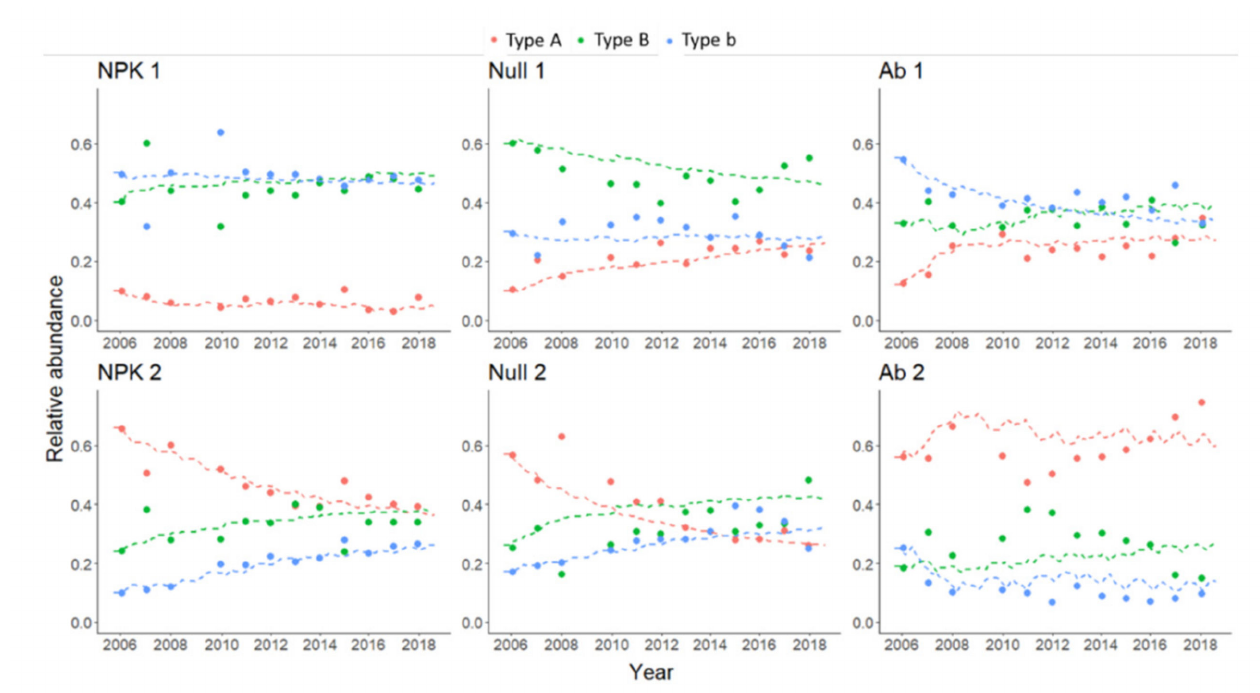
Figure 3. Observed (dots) and ModVege-CoSMo simulated (lines) fluctuations in the relative abun- dance of plant (grass) functional types in three treatments (NPK: fertilised; Null: unfertilised; Ab: abandoned) and two blocks (1, 2). Type A: grass species of fertile environments, small, with early phenology and a short life span of the leaves; Type B: grass species of fertile environments, larger, with moderately early phenology and a longer leaf life than type A; Type b: grass species preferring rela- tively fertile environments but differing from the two previous groups in their late phenology.